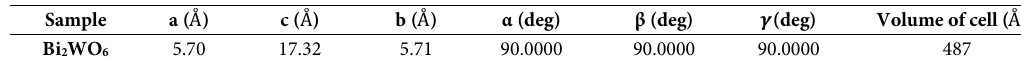
Figure 3. FEEM image, and (b) size distribution of Bi 2 WO 6 NPs